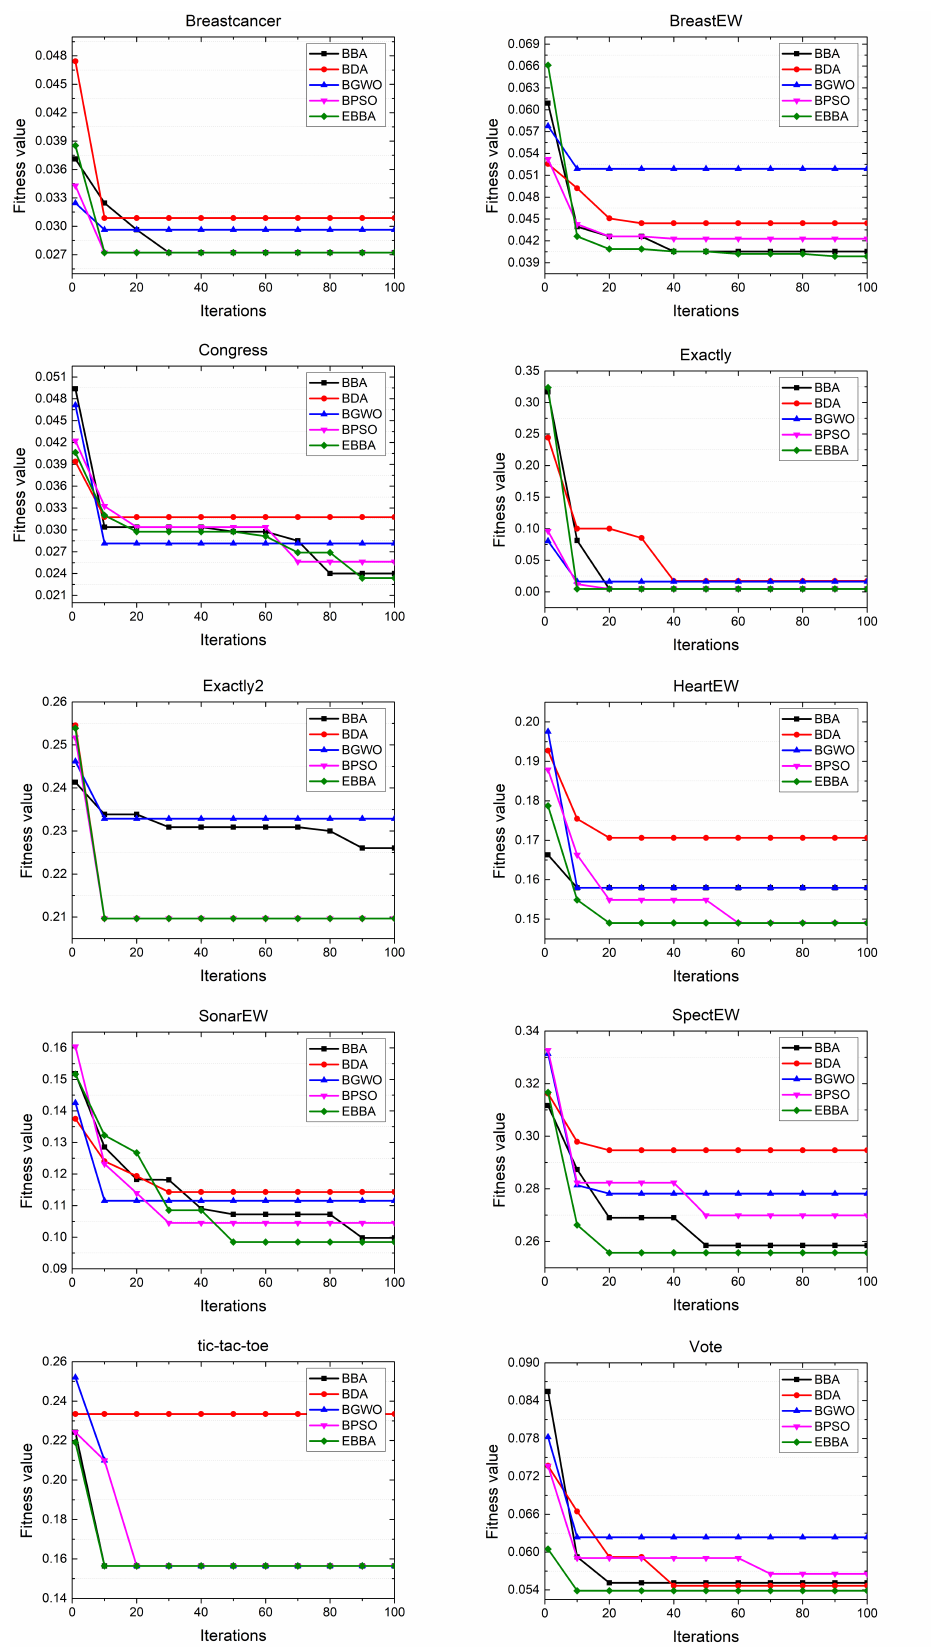
Figure 2. Convergence rates achieved by various